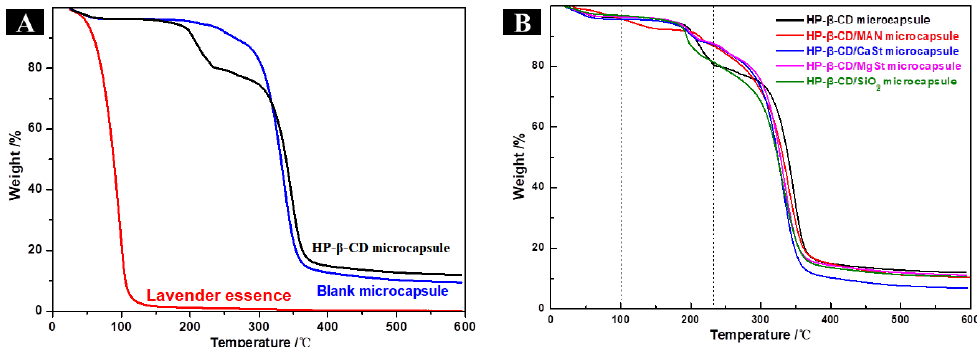
Figure 4. Thermal analysis of microcapsules with different anticaking agents. ( A ) Thermal gravimetric analysis (TGA) patterns of lavender essence, HP- β -CD microcapsules, and blank microcapsules. ( B ) TGA patterns of microcapsules with anticaking agents.